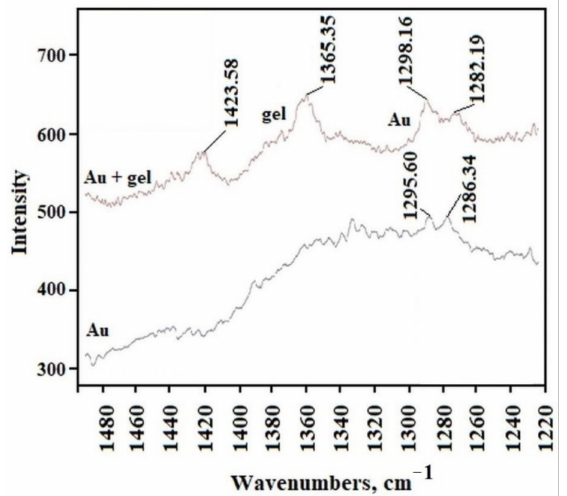
Figure 5. The comparison of Raman spectra for C 12 ALA-AuNP and gold